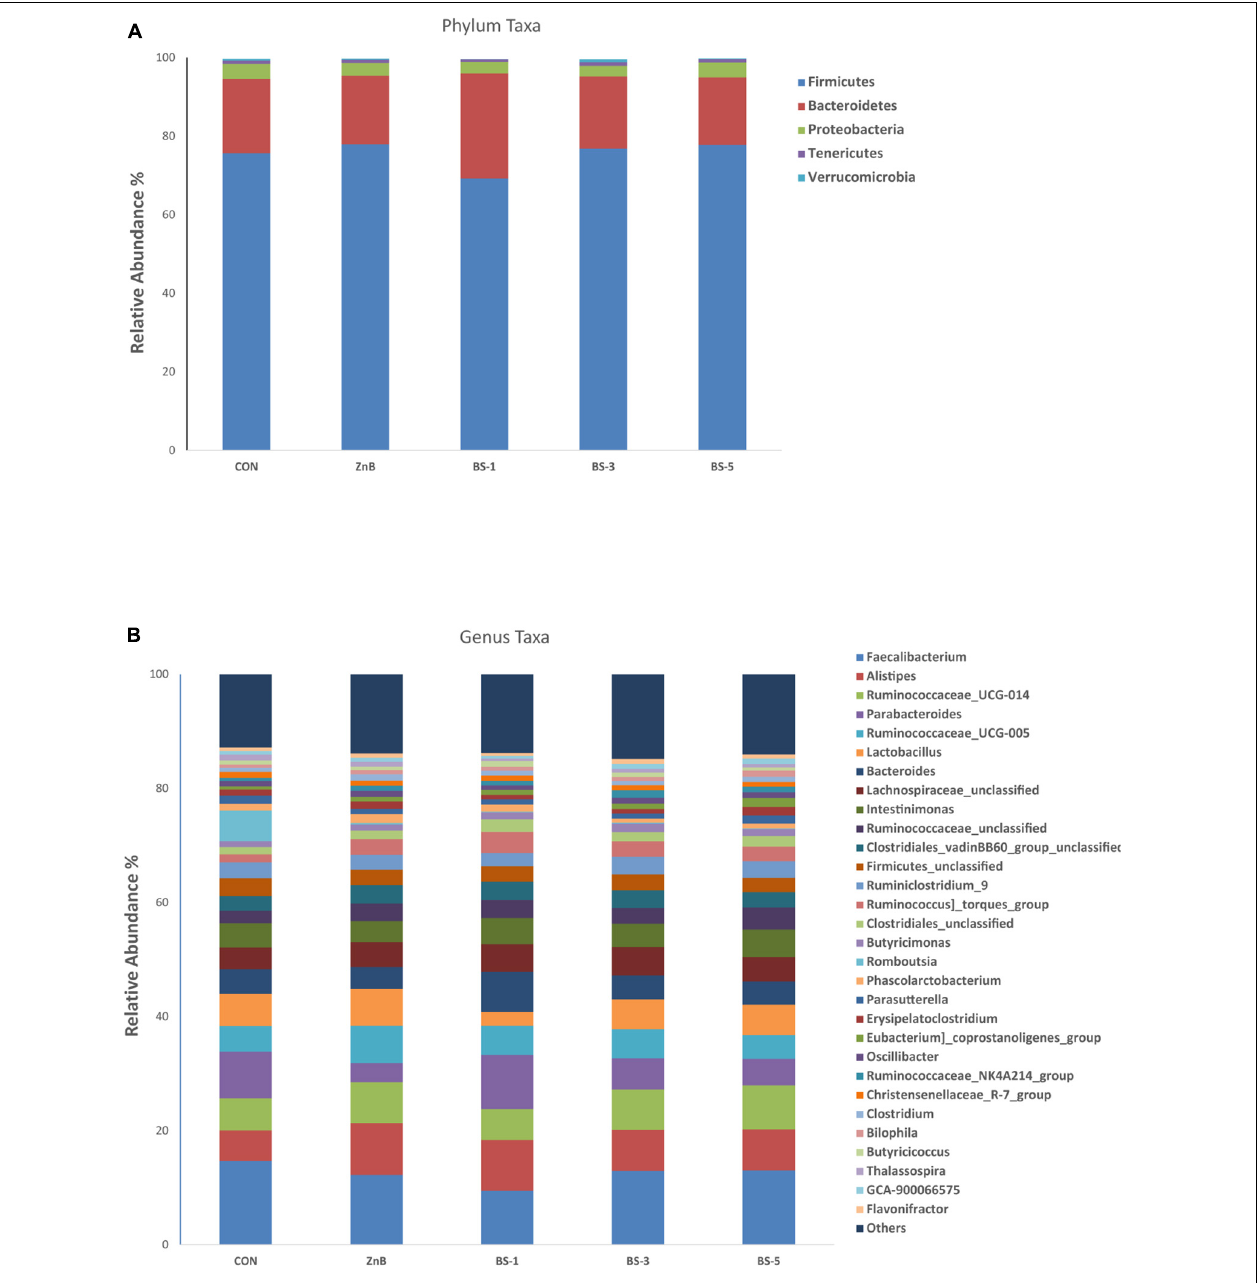
FIGURE 3 | Effect of dietary supplementation of Bacillus subtilis ATCC19659 on the relative abundance of cecal microbiota communities at phylum (A) and genus (B) . CON, chicks were fed a corn- and soybean-based diet; ZnB, chicks were fed basal diet containing 500 mg ZnB/kg; BS-1, chicks were fed basal diet containing 1 × 10 8 CFU/g feed of BS- ATCC19659; BS-3, chicks were fed basal diet containing 3 × 10 8 CFU/g feed of BS- ATCC19659; BS-5, chicks were fed basal diet containing 5 × 10 8 CFU/g feed of BS-